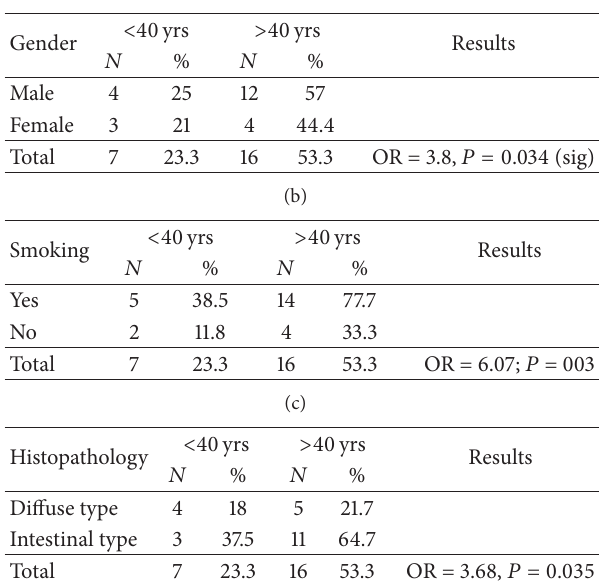
Table 2: (a) p53 gene analysis in studied group of ca stomach patients. (b) p53 gene analysis in studied group as per smoking status. (c) p53 gene analysis in studied group as per